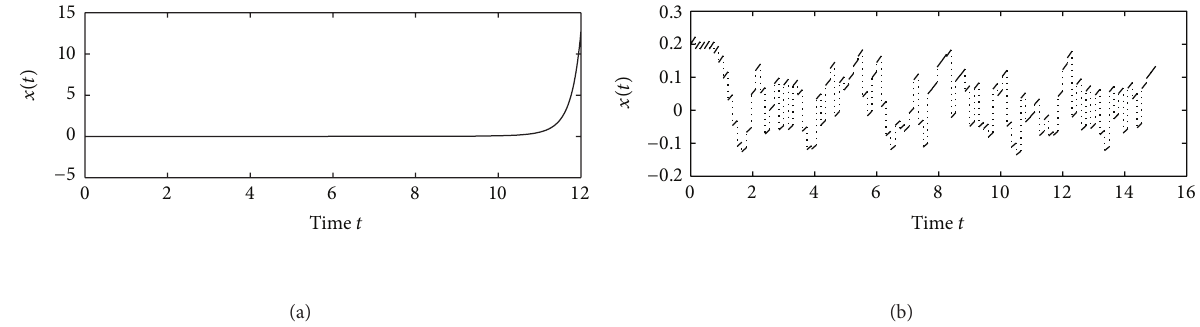
Figure 1: The trajectory of (36) with: (a) no impulse (i.e., Δ𝑥 = 0 ) and (b) impulses.